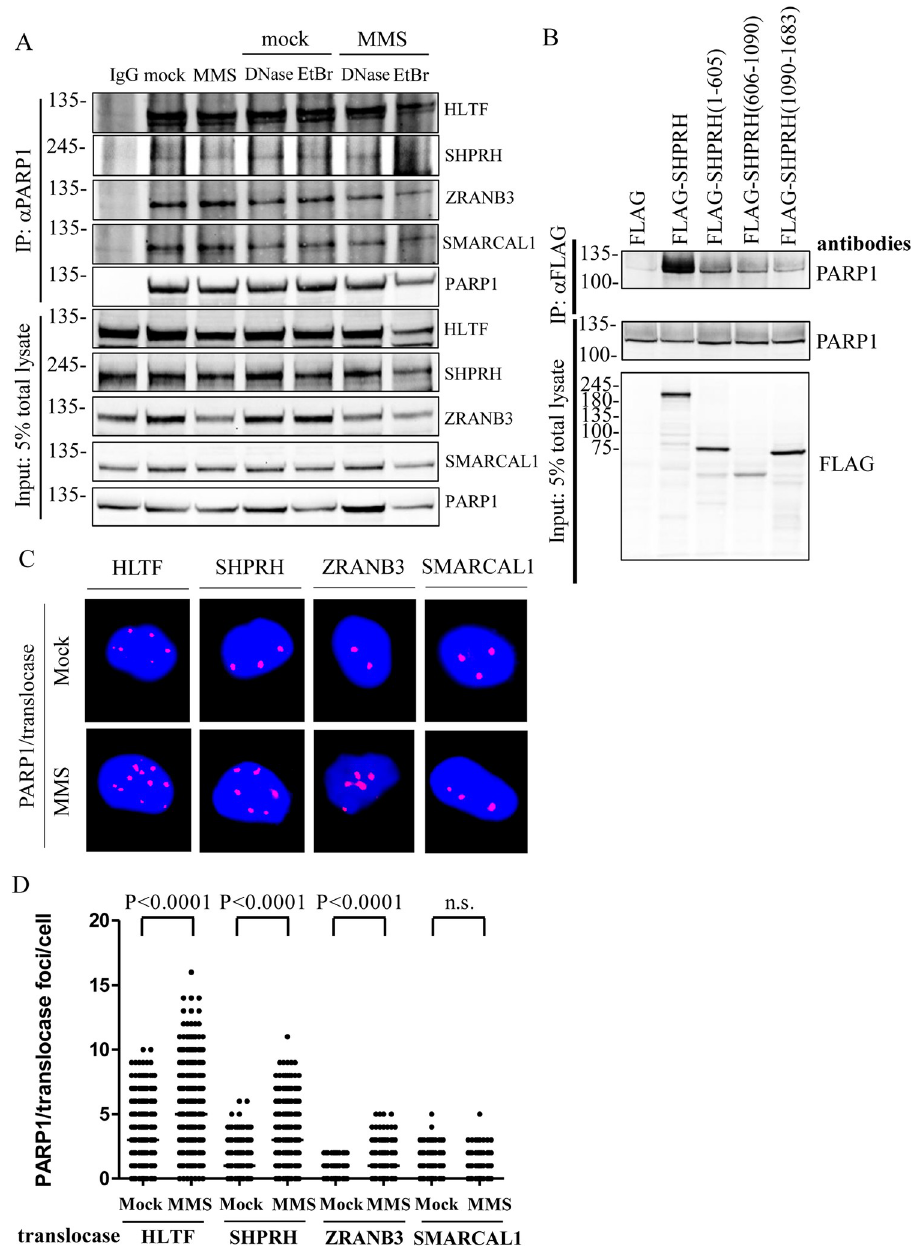
Fig 3. PARP1 interacts with DNA translocases in vivo . (A) The endogenous protein–protein interaction between PARP1 and translocases. Cells were treated with either mock or 0.01% MMS for 1 hour. Cell lysates were treated with either 100 μ g/ml DNase I or 50 μ g/ml EtBr as indicated. The endogenous PARP1 was immunoprecipitated with an anti-PARP1 antibody and the pulldown translocases were detected with specific antibodies as indicated. The non- specific mouse IgG was used as a negative control. Input represents 5% of total cell lysates. (B) The N-terminal domain of SHPRH interacts with PARP1. HEK293T cells were transfected with various FLAG–SHPRH constructs. The FLAG-SHPRH fusion proteins were immunoprecipitated with anti-FLAG sepharose beads, and the immunoprecipitates were then subjected to immunoblotting analysis. Input represents 5% of total cell lysates. (C) Representative images of HLTF, SHPRH, ZRANB3, and SMARCAL1/PARP1-PLA foci in T24 cells, respectively. Cells were treated with 0.01% MMS for 1 hour. The association of each translocase with PARP1 was determined by the PLA assay. (D) Distributions of HLTF, SHPRH, ZRANB3, and SMARCAL1/PARP1-PLA foci derived from C. At least 200 cells from each condition were measured. (Raw PLA data in S3 Data).